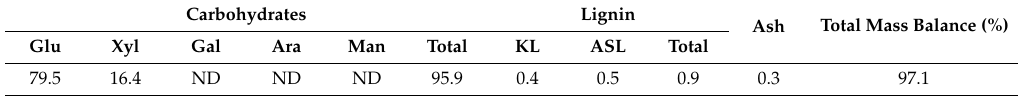
Table 1. Chemical composition of the bleached hardwood